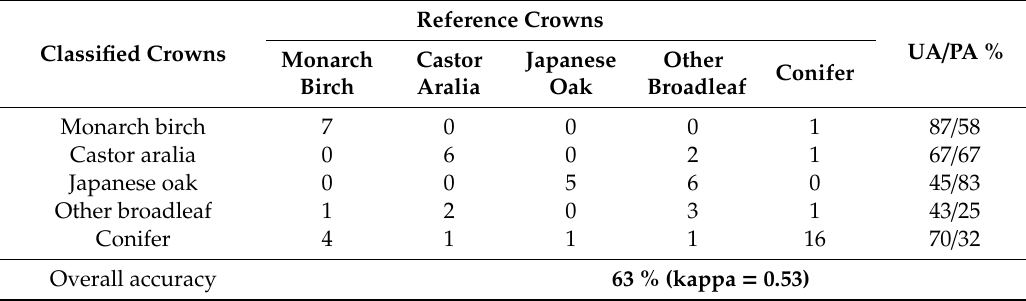
Table 6. Confusion matrix for RF classification of broadleaf species into high-value timber species and other broadleaf species based on 58 validation crowns from known tree positions in sub-compartment